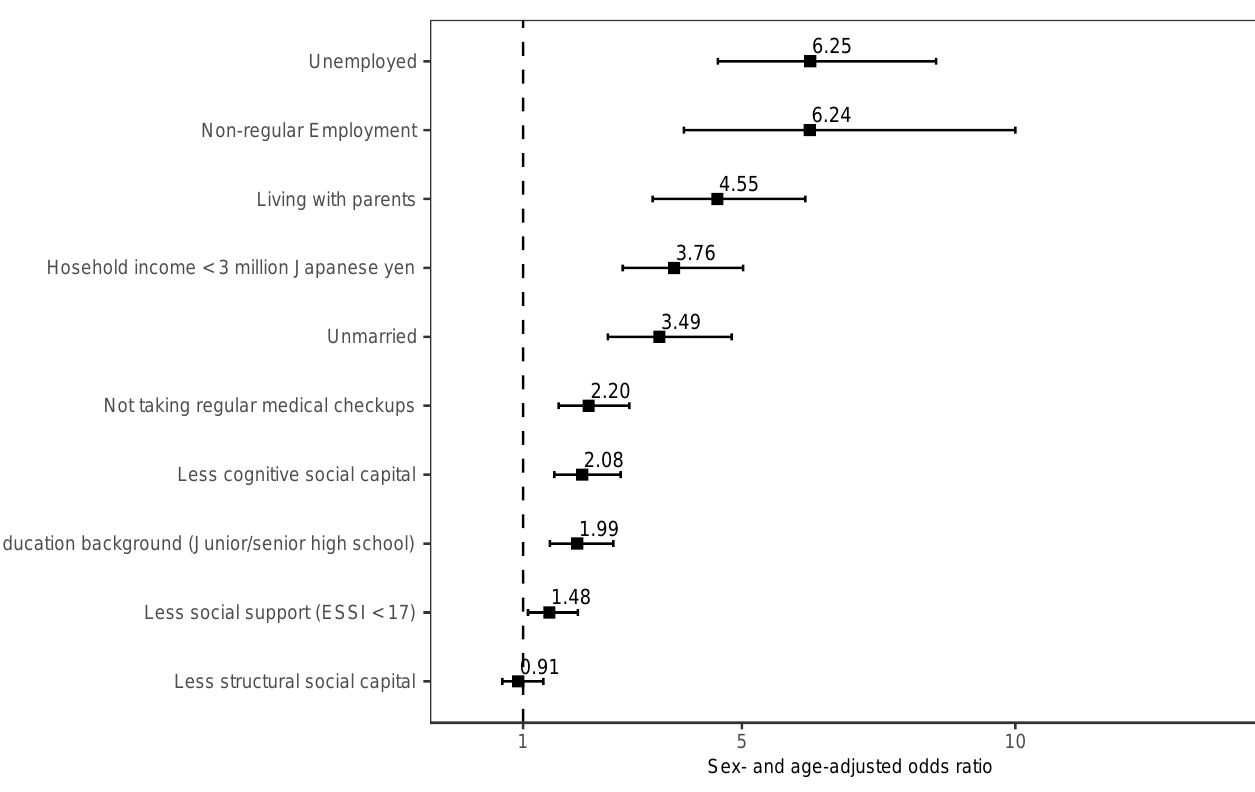
Figure 3. Sex- and age-adjusted odds ratios of participants with schizophrenia compared to partici- pants without schizophrenia in terms of social comorbidities. Abbreviations: ESSI, the ENRICHD Social Support Instrument.